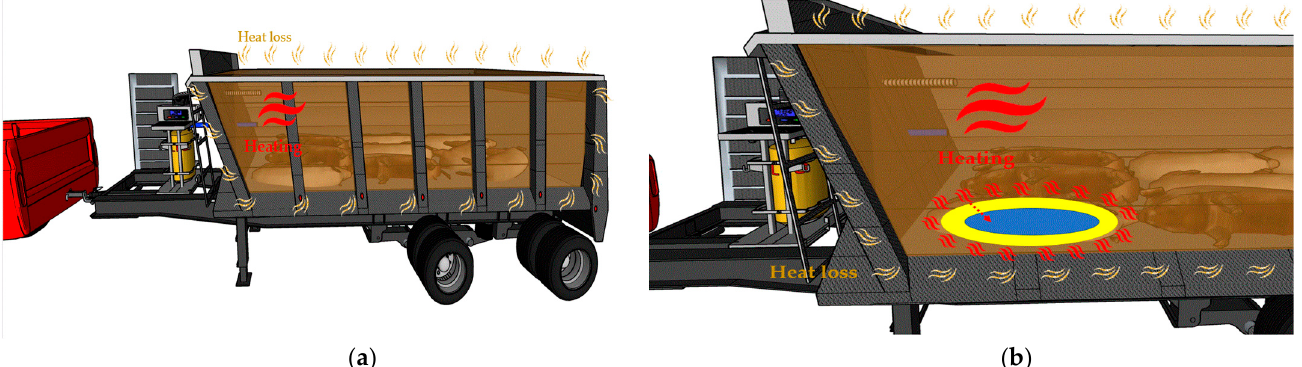
Figure 4. Pathogen inactivation in carcasses by heat. Combustion gas fills the trailer volume, and